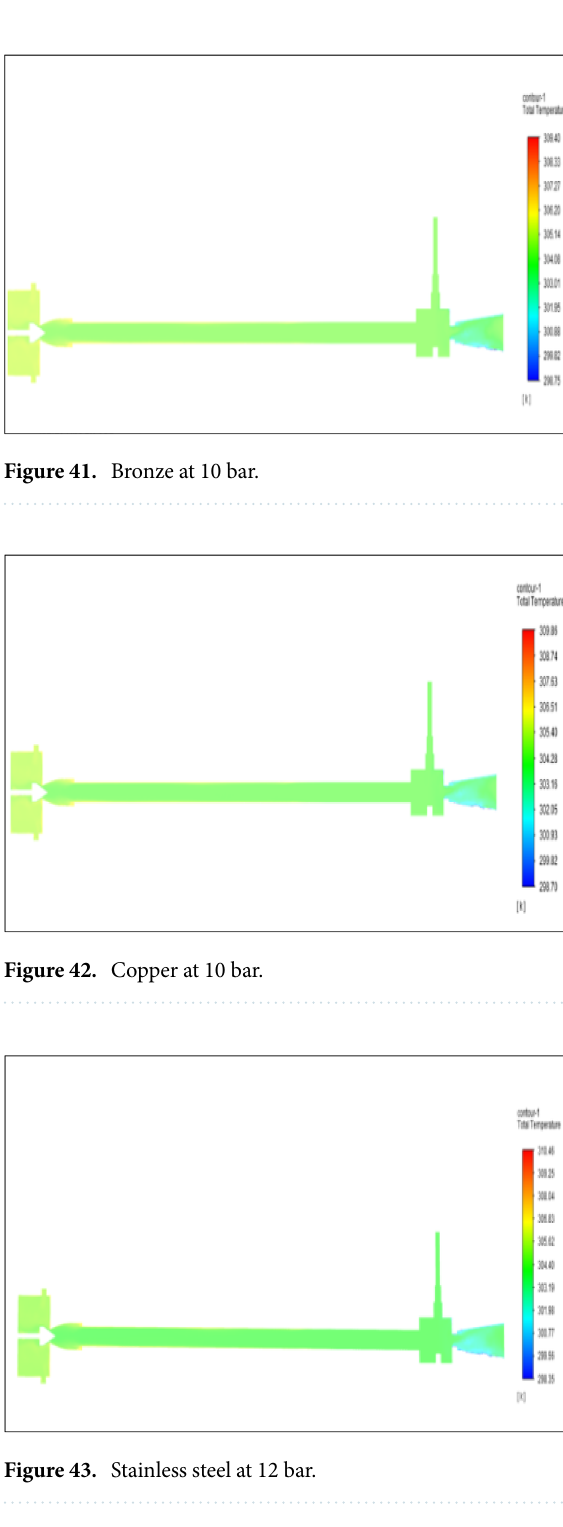
Figure 43 related to stainless steel vortex tube with an inlet pressure of 12 bars. The inlet temperature of the VT is 303 K. The hot air temperature was obtained at the hot end as 310.46 K. Similarly at the cold end side obtained value was 298.35 K. The maximum temperature difference was noticed as 12.11 K. Figure 44 related to a brass vortex tube with an inlet pressure of 12 bars. The inlet temperature of the VT is 303 K. The hot air temperature was obtained at the hot end as 310.47 K. Similarly at the cold end side obtained value was 298.13 K. The maximum temperature difference was observed as 12.34 K.